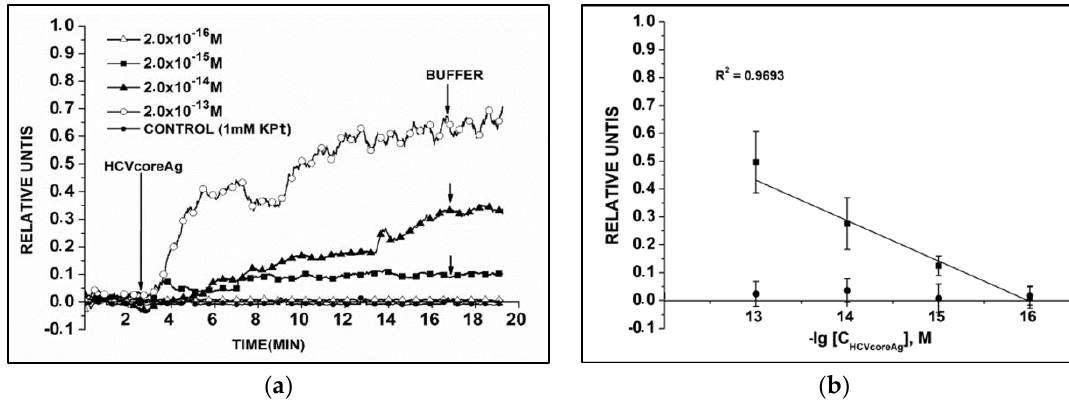
Figure 3. Results obtained upon the detection of HCVcoreAg (the core antigen of hepatitis C virus) protein in acidic buffer using p-type SOI-NW chip with covalently immobilized aptamers: ( a ) typical sensogram curves obtained upon analysis of solutions with various HCVcoreAg concentration. Arrows indicate the addition of HCVcoreAg solution and wash with buffer; ( b ) dependence of the signal level on HCVcoreAg concentration (three technical replicates, n = 3). Circles (●) and squares ( ■) indicate average signal level before and after addition of protein solution, respectively. Experimental conditions: protein concentration: 2.0 × 10 − 16 M; 2.0 × 10 − 15 M; 2.0 × 10 − 14 M; 2.0 × 10 − 13 M, V g ( − 45) V, V ds ( − 0.2) V. 1 mM potassium phthalate buffer, pH 5.1.